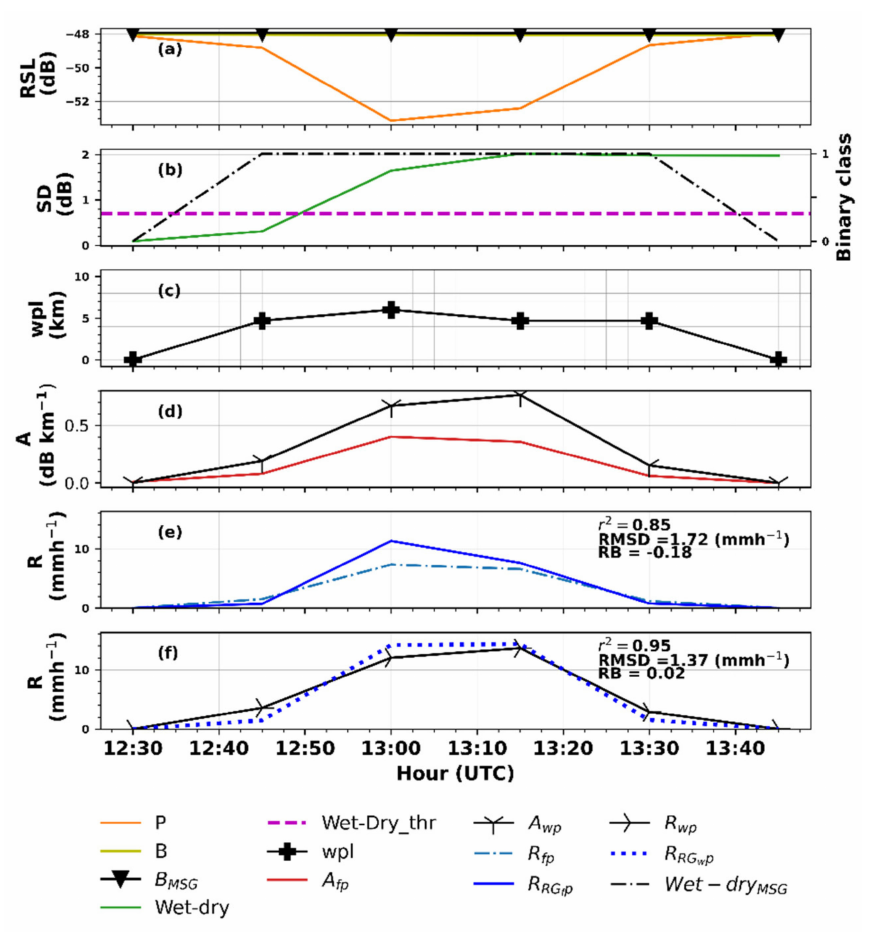
Figure 5. ( a – f ) As in Figure 3 but for 15 min interval rain events of 9 June